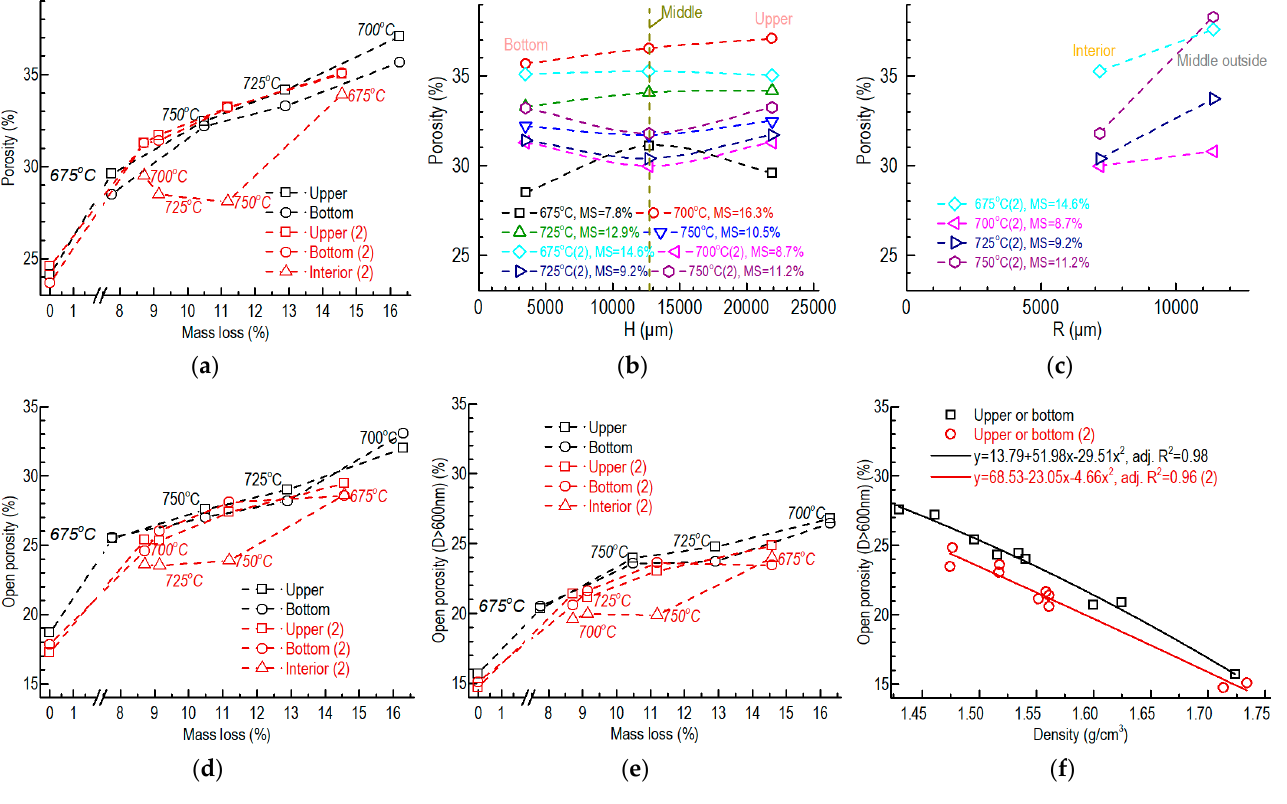
Figure 7. Porosities of pure graphite specimens oxidized based on the conditions of ASTM D7542: ( a ) porosities of different parts versus mass loss of whole specimen; ( b ) axial distribution of the porosity of the specimen; ( c ) radial distribution of the porosity of the middle part of the specimen; ( d ) open porosities of different parts versus mass the loss of the whole specimen; ( e ) open porosities (D > 600 nm) of different parts versus the mass loss of the whole specimen; ( f ) fitting results of the open porosities (D > 600 nm) and densities of different upper and bottom parts.